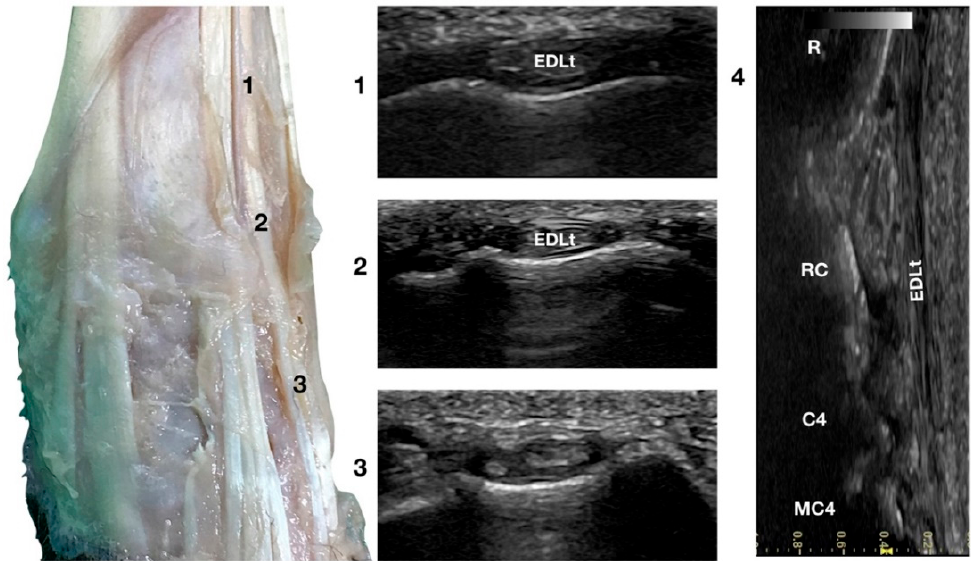
Figure 4. Dorsal carpal face centred on the Extensor Digitorum Lateralis tendon. At the ulnar notch level (2), the EDLt is seen as a thin oval tendon embedded in the deep Extensor Lateralis groove. Proximally (1), the tendon is thicker. The EDLt divides into two parts distally at the intercarpal joint (3). On the longitudinal scan plane (4), the fine fibrillar pattern of the thin medial tendon is visible. The bony surface beneath is recognisable. R, radius; RC, radiocarpal bone; C4, carpal bone four; MC4, fourth metacarpal